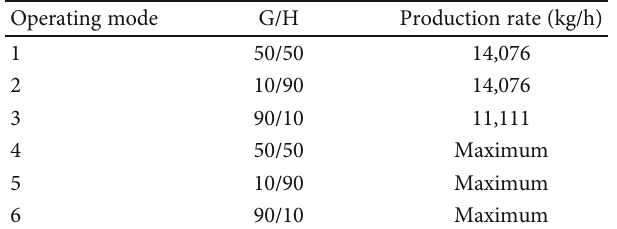
Table 1: Operation modes of the TE process. Operating